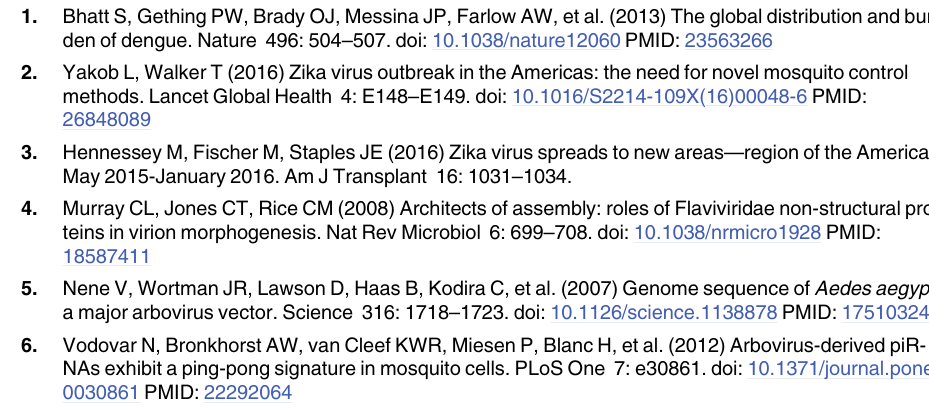
S1 Table. List of primers used in this study. S2 Table. Identified lincRNA candidates in Ae . aegypti and their genome coordinates. S3 Table. Differentially expressed lincRNAs in response to DENV-2 infection in midgut and